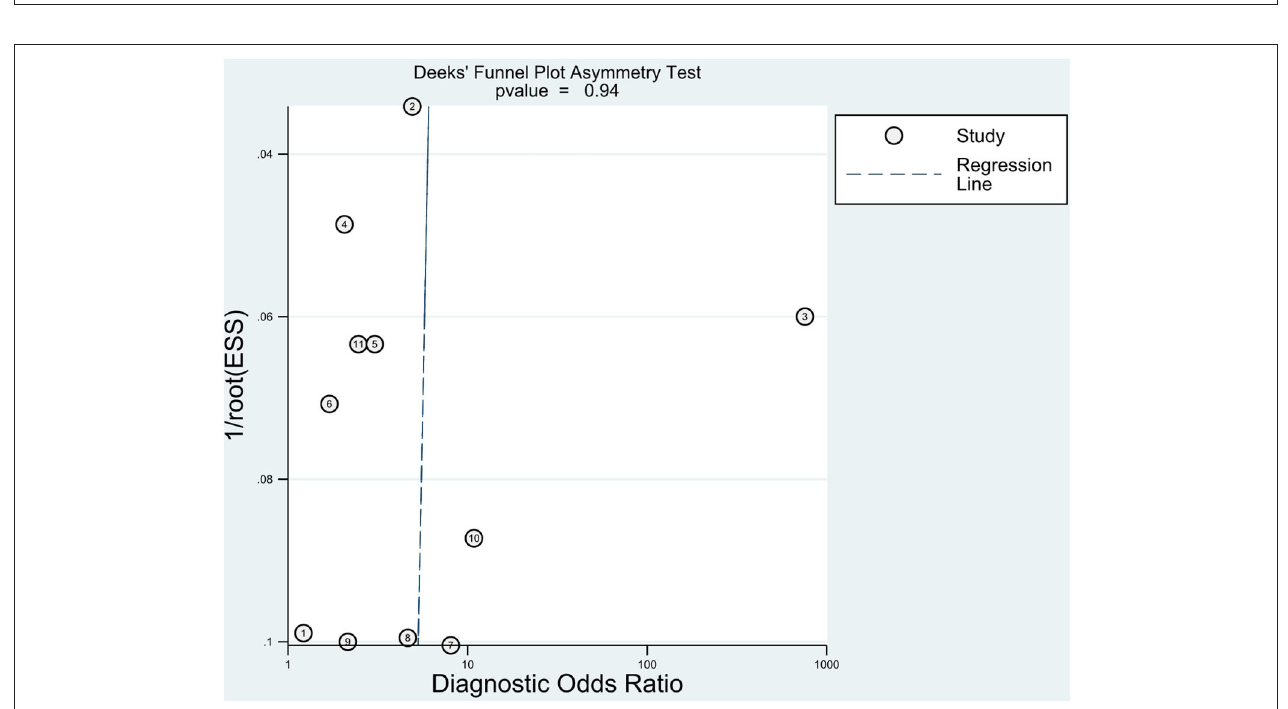
FIGURE 7 | Publication bias. The Deek’s test was established to evaluate publication